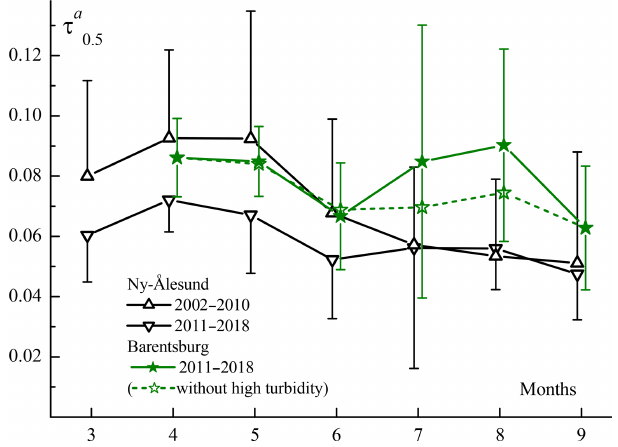
Figure 9. The interrelation between daily AOD (0.5µm) values Figure 8. Seasonal average τ a variations in Ny-Ålesund and Bar- measured in Ny-Ålesund and Barentsburg (2011–2018). The solid 0 . 5 entsburg. line shows the unconstrained linear regression, and the dotted line shows the regression through the origin (0,0).